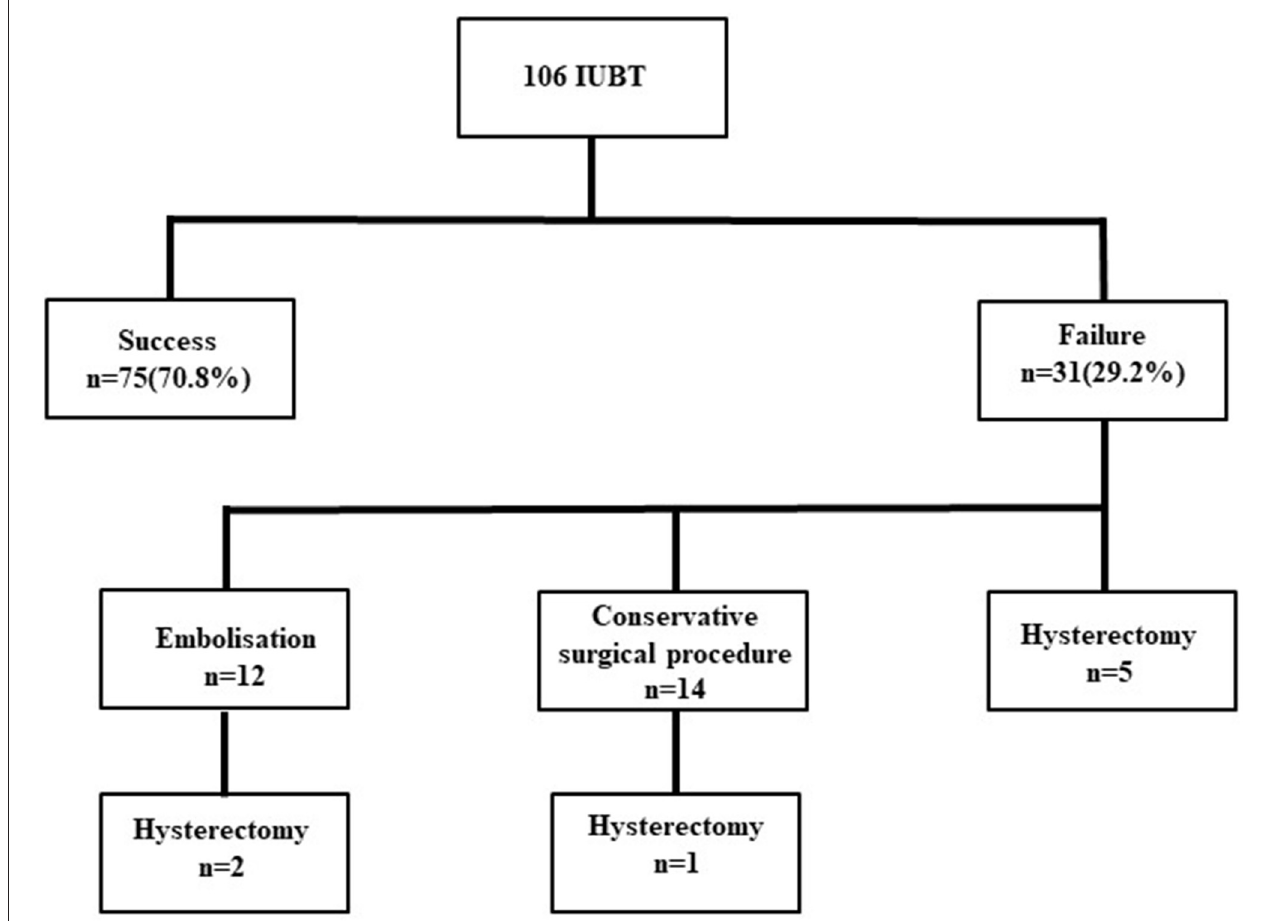
FIGURE 1 | Flowchart. IUBT, intrauterine balloon